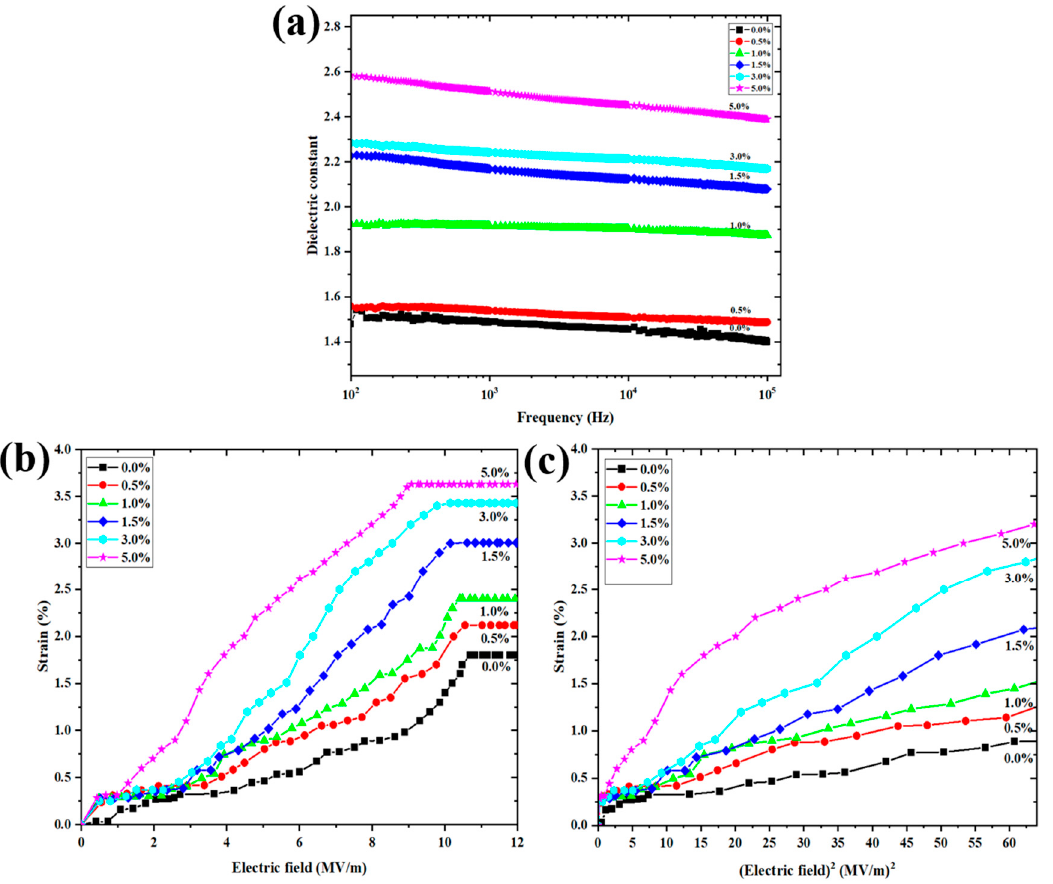
Figure 7. ( a ) Dielectric constant; ( b ) strain as a function of electric field at 1 Hz and ( c ) strain as a function of E 2 for pure and P(VDF-HFP)/PANI composite nanofibers. Table 3. Evaluated dielectric constant ( ε r ), loss tangent, conductivity ( σ ), Young’ modulus ( Y ) and electrostrictive coefficient ( M 33 ) of pure and P(VDF-HFP)/PANI composites. P(VDF-HFP)/PANI